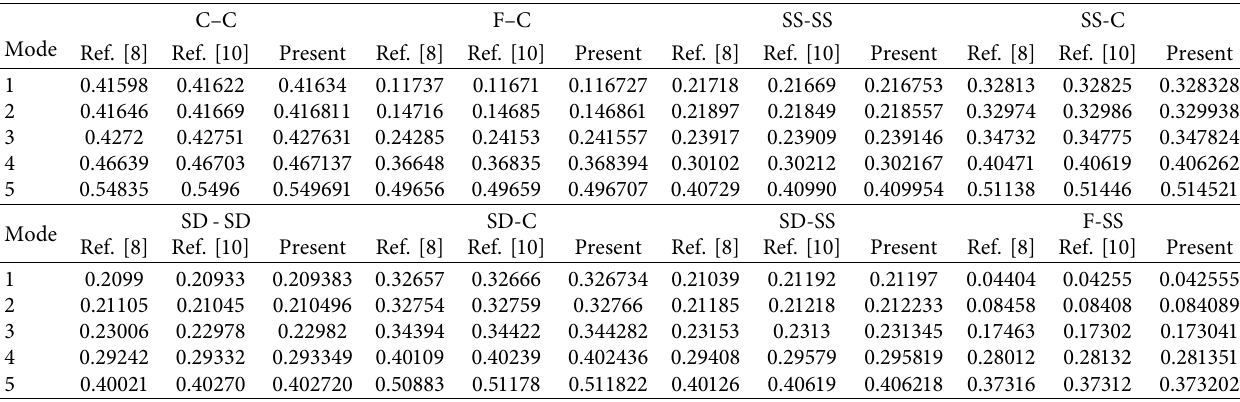
Table 4: Comparison of the first five frequency parameters Ω � ω R2( ρ h/A11)1/2 for composite laminated annular plate with